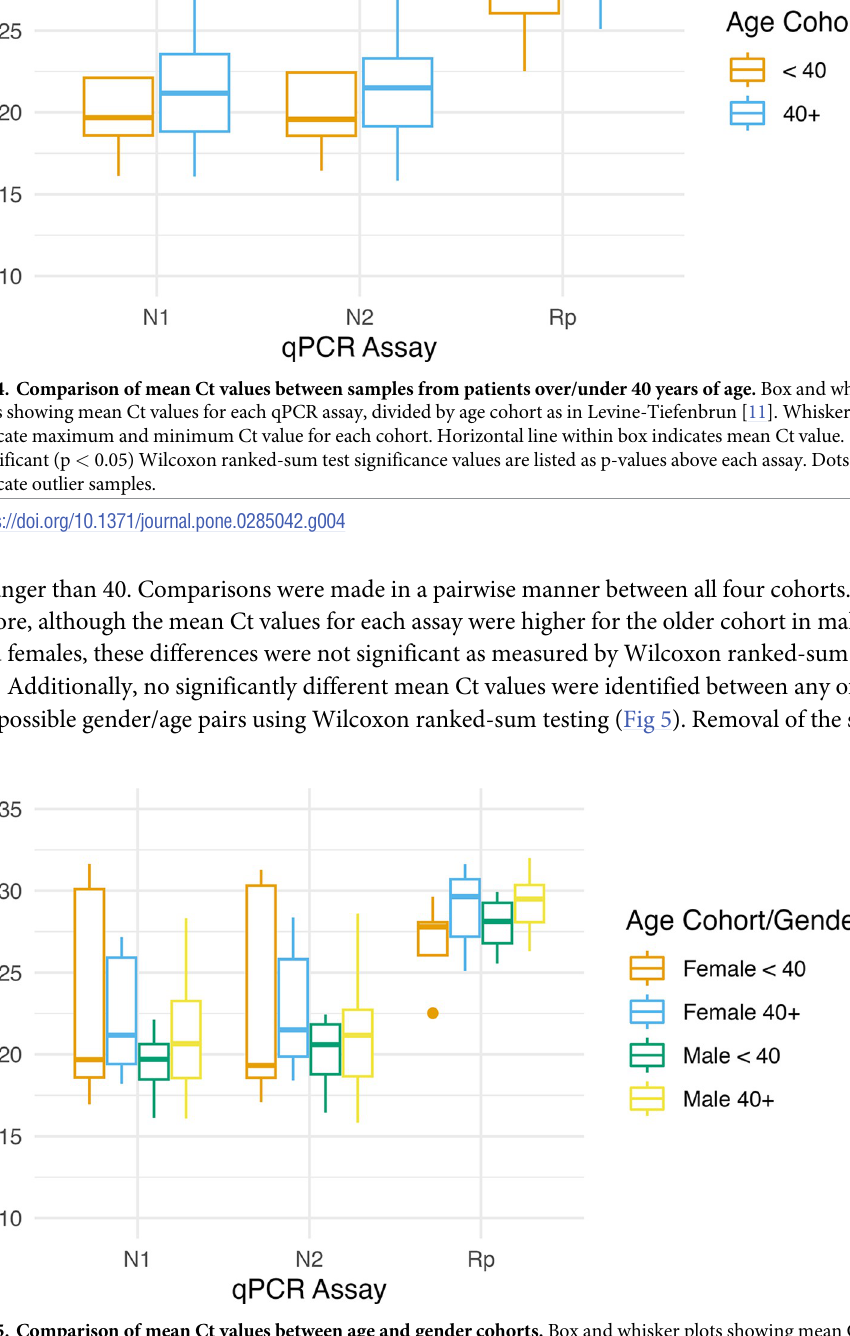
Fig 5. Comparison of mean Ct values between age and gender cohorts. Box and whisker plots showing mean Ct values for each qPCR assay using the same data as in Fig 3, parsed further by gender. Whiskers indicate maximum and minimum Ct value for each cohort. Horizontal line within box indicates mean Ct value. Dots indicate outlier samples.